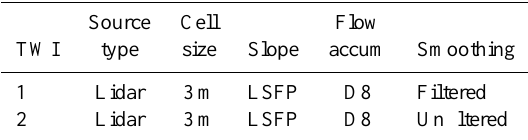
Table 3. Example of TWI differences in pairwise